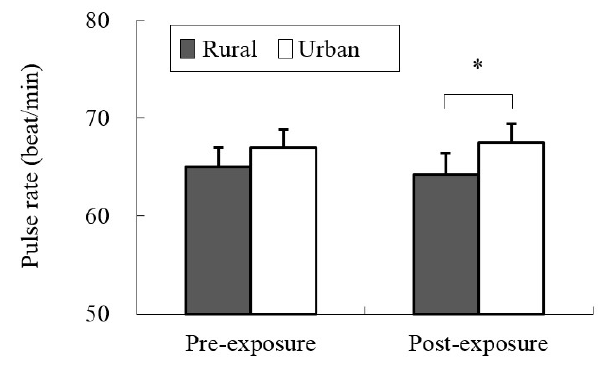
Figure 3. Comparison of systolic (top) and diastolic blood pressures (middle) and pulse rate (bottom) between the rural and urban at pre- and post- exposure sessions. Mean ± SE;